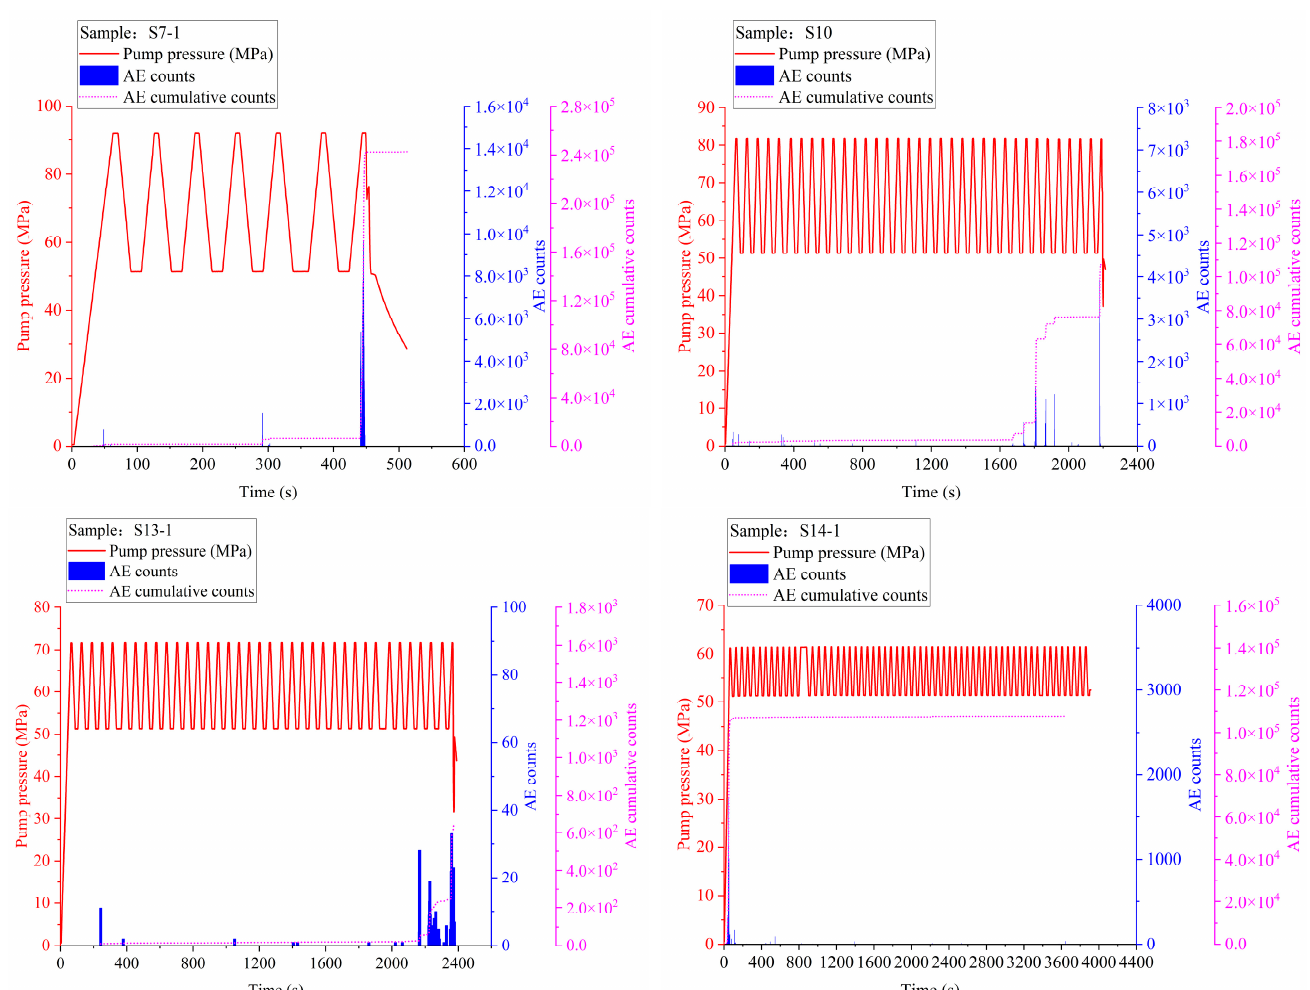
Figure 14. The relationship between the AE cumulative counts and injection time of the samples.